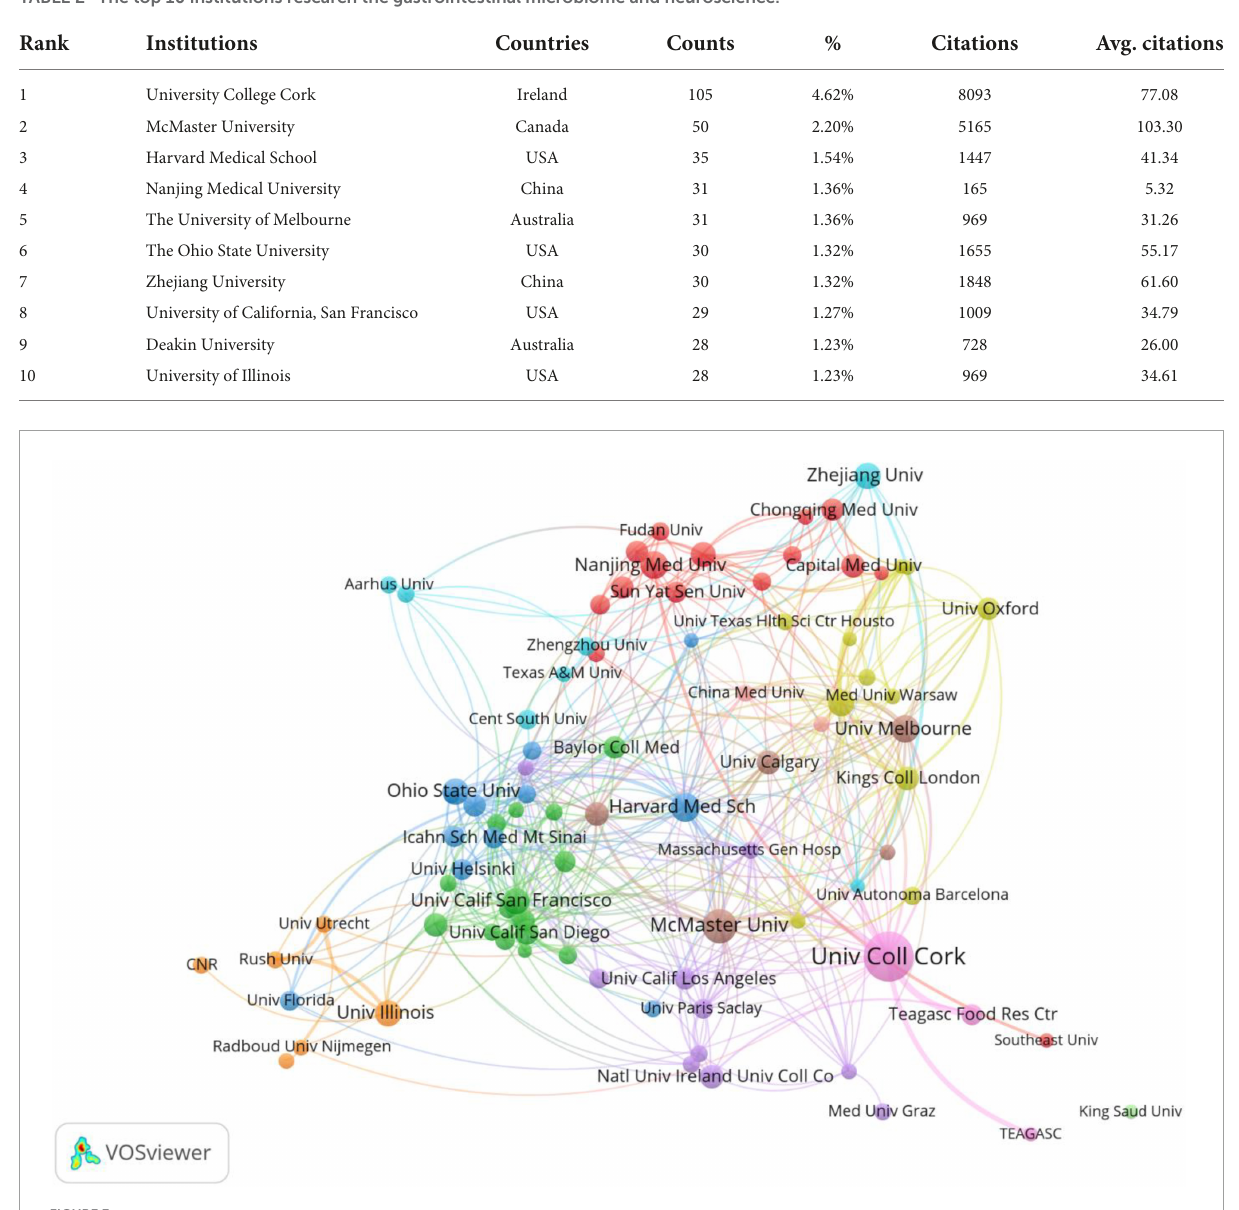
gastrointestinal microbiome and neuroscience was Cryan